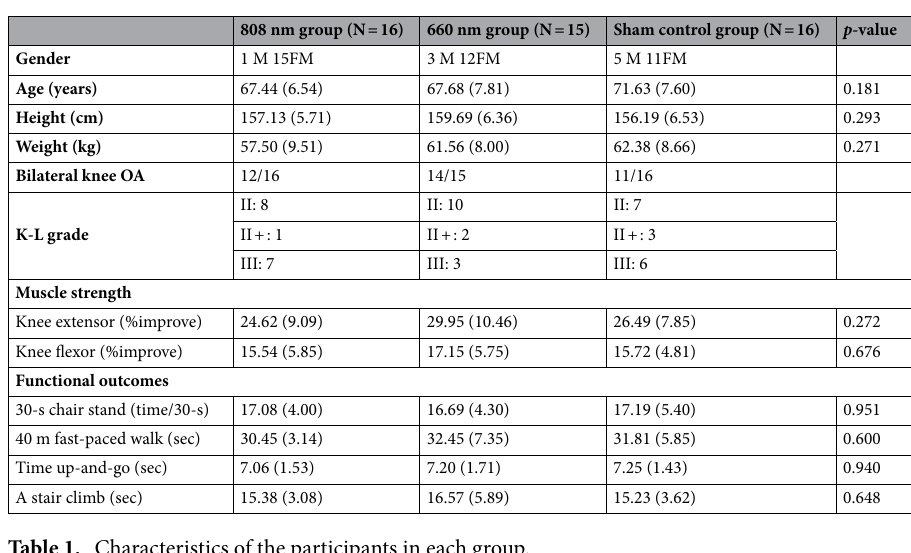
Table 1. Characteristics of the participants in each group.